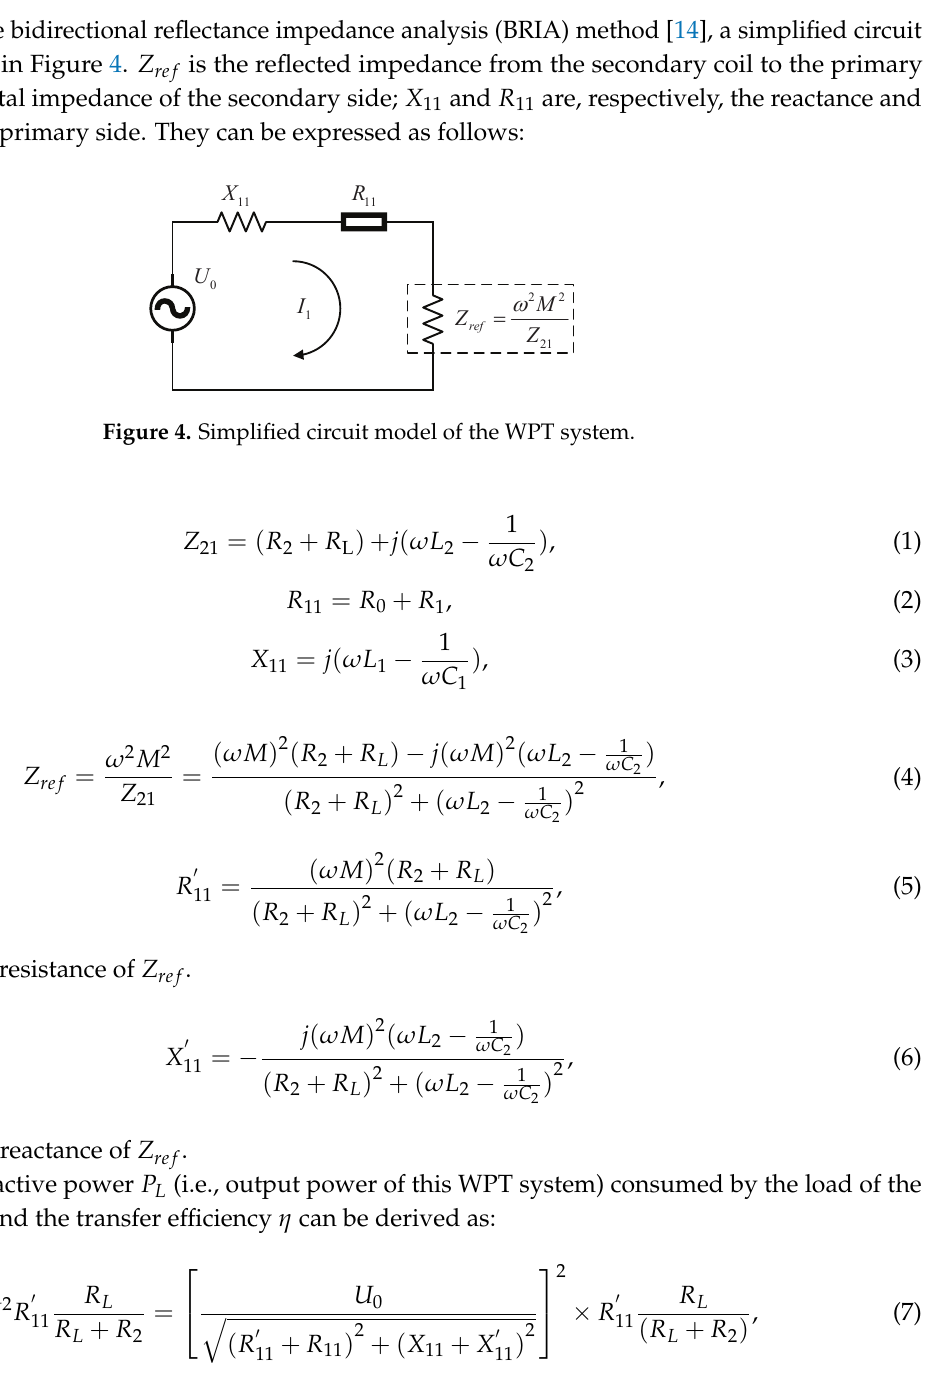
Figure 3. ( a ) Circuit model of the WPT system; ( b ) Equivalent circuit model of the WPT system.